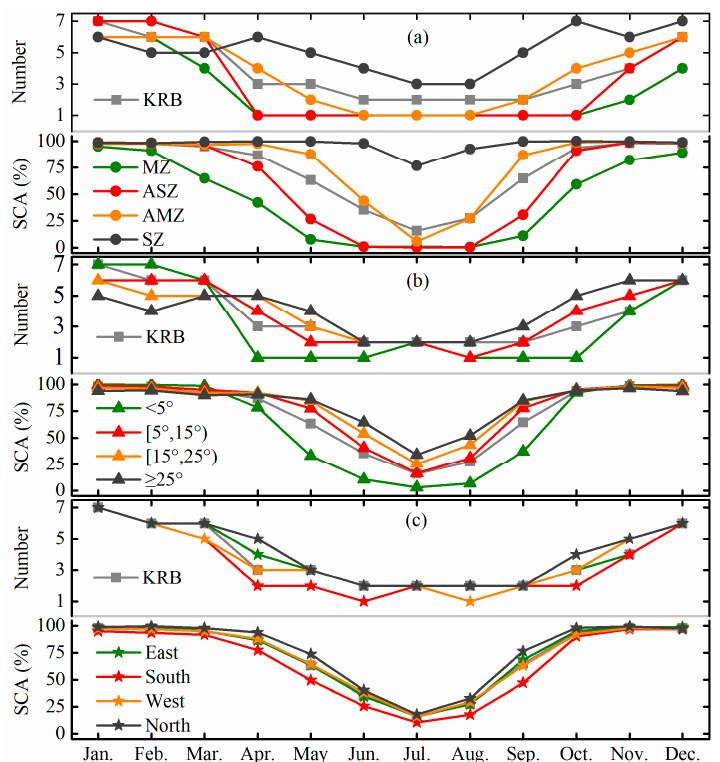
Figure 13. Monthly median frequency of snowfall and snow-covered areas (SCAs) at each elevation zone ( a ), slope ( b ), and aspect ( c ) over the KRB from June 2000 to May 2020. MZ = montane zone, ASZ = alpine steppe zone AMZ = alpine meadow zone, and SZ = snow zone.